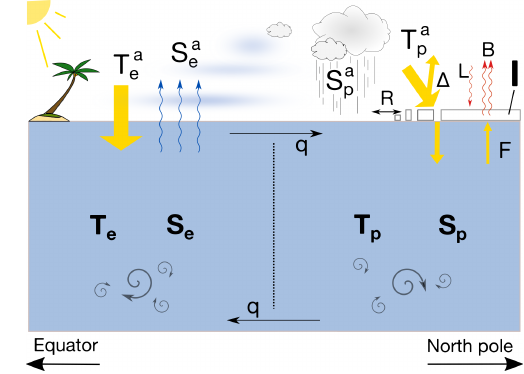
Figure 2. Schematic of the coupled sea ice–ocean model including model parameters and variables (bold). A description of the param- eters is given in Table 1. The well-mixed polar and equatorial ocean boxes are coupled by a surface flow q , along with an identical re- turn flow at the bottom. The ocean component is reduced to the two variables T ∝ T e − T p and S ∝ S e − S p . In the polar ocean box, the sea ice cover I insulates the ocean from the cold atmospheric tem- perature T a p .